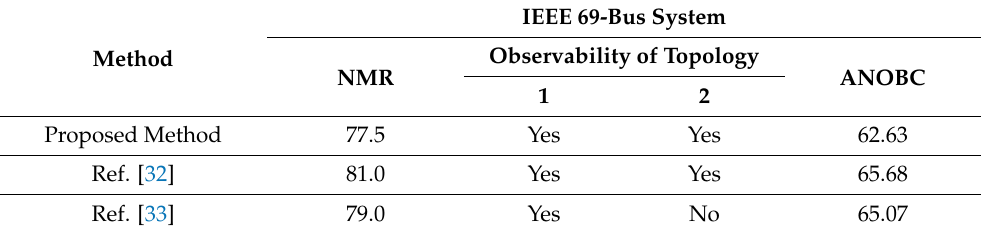
Table 4. Comparison of multiple indicators of IEEE 69-bus system.